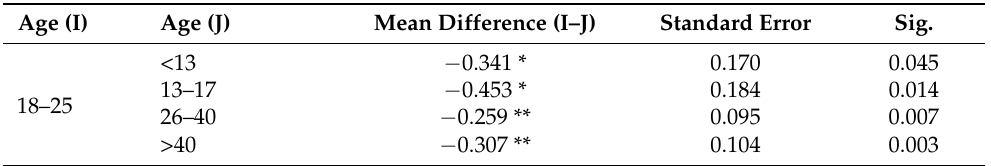
Table 10. Post hoc test results with age as independent variable and stress restoration index as dependent variable.